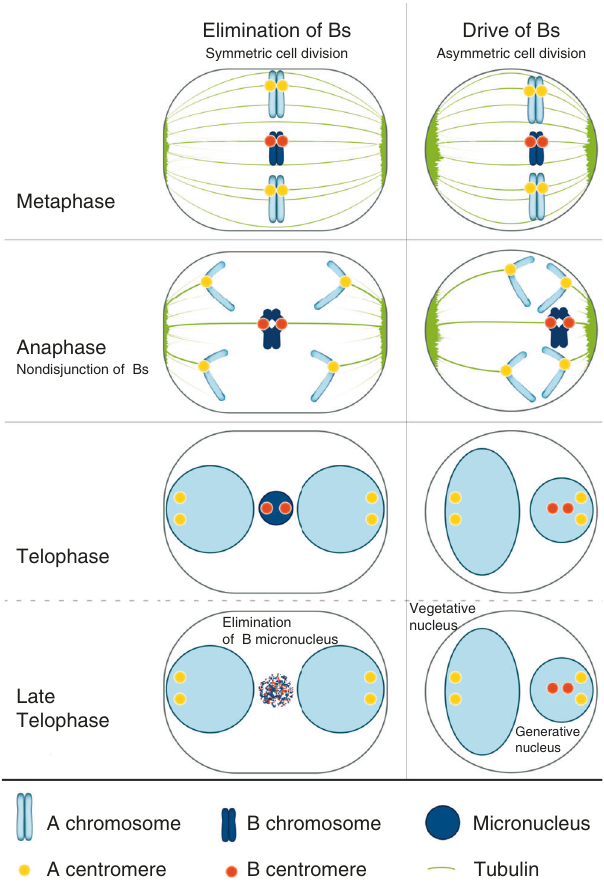
Fig. 5 Schematic comparison of the cellular process of B elimination with the process of post-meiotic B chromosome drive reveals striking similarities. In both processes, nondisjunction of Bs occurs despite centromere activity and centromere-tubulin interaction. Spindle symmetry differs between the two processes: during the fi rst pollen mitosis an asymmetric cell division occurs whereas the spindle in roots is symmetrical. Therefore, in roots, lagging B chromosomes form micronuclei and undergo elimination. In contrast, due to the asymmetric geometry of the spindle at fi rst pollen mitosis, the inclusion of the lagging joint B chromatids in the generative nucleus takes place and chromosome accumulation